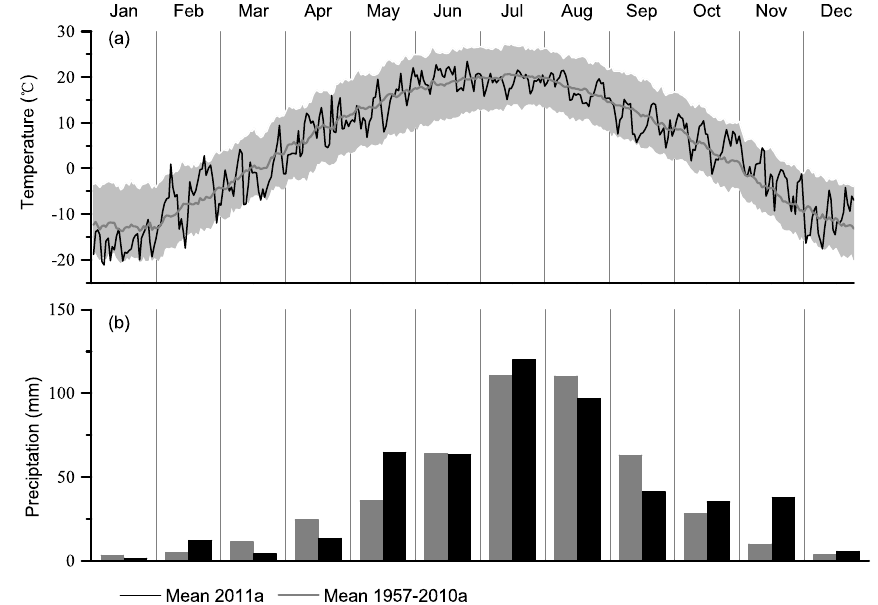
Figure 2. Comparison of the mean daily air temperatures ( a ), and the monthly sums of precipitation ( b ) for the monitoring year 2011 (black) and the 1957–2010 average (grey). The grey shading in ( a ) indicates the mean minimum and maximum temperatures averaged over the 1957–2010 period. Data were obtained from the nearest State standard meteorological station in Wuzhai (38°55′ N, 111°49′ E, 1401 m a.s.l., linear distance ca. 20 km north of the study